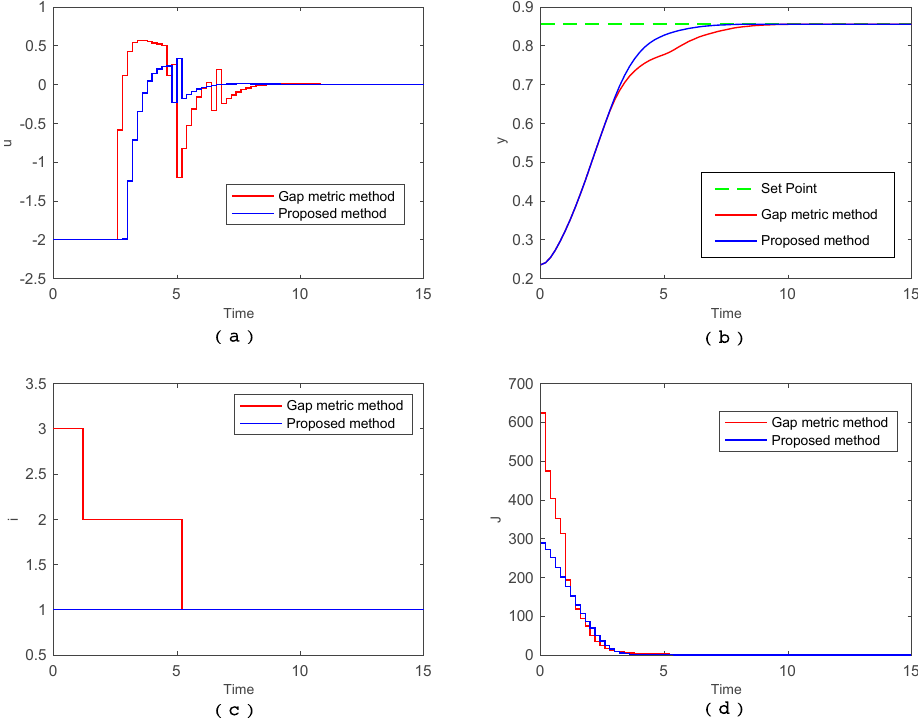
Figure 4. Simulation profile of multiple model predictive control with two decomposition results. ( a ) The input u profile of multiple model predictive control with two methods; ( b ) the output y profile of multiple model predictive control with two methods; ( c ) the mode i profile of multiple model predictive control with two decomposition results, and ( d ) the objective function J profile of hybrid-model-based MPC with two